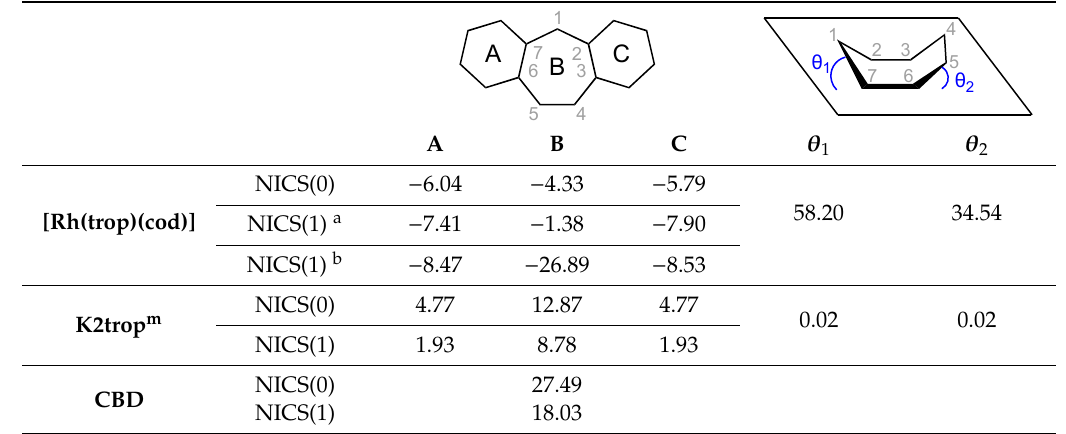
Table 5. Calculated isotropic NICS(0) and NICS(1) values for trop + , trop ‒ , model compounds Mtrop m (M = Li, Na, K) and K 2 trop m , [Rh(trop)(cod)] and cyclobutadiene (CBD). The model compounds do not contain solvent molecules attached to the alkali cations. Computational details: PBE [38,39] 6- 311+G(df, pd) [40] in a continuum solvation model (THF). Abbreviations: θ 1 and θ 2 : dihedral angles of the optimized structures (°), CBD: 1,3-cyclobutadiene.